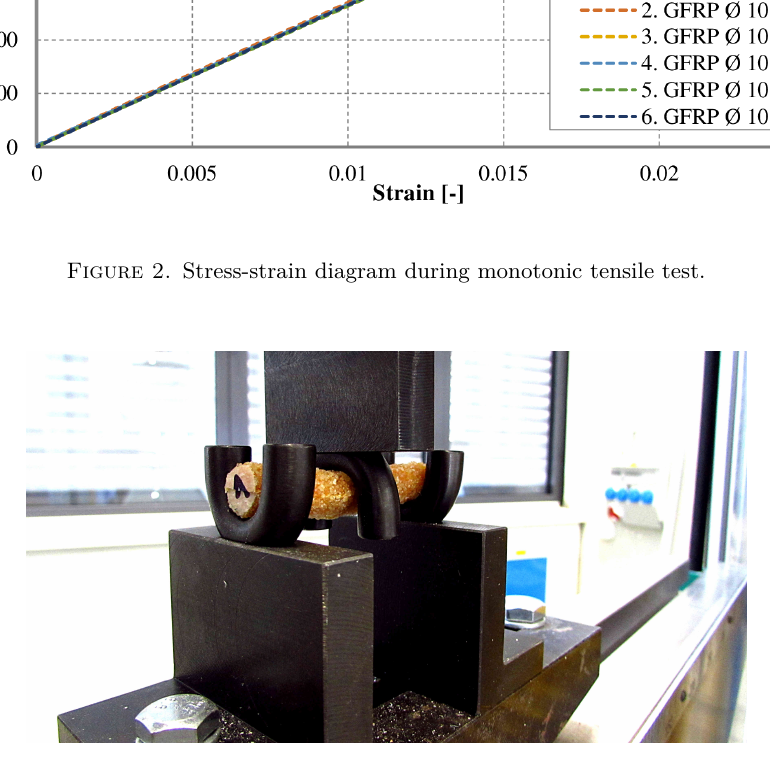
Figure 3. Configuration of interlaminar (longitudinal) shear